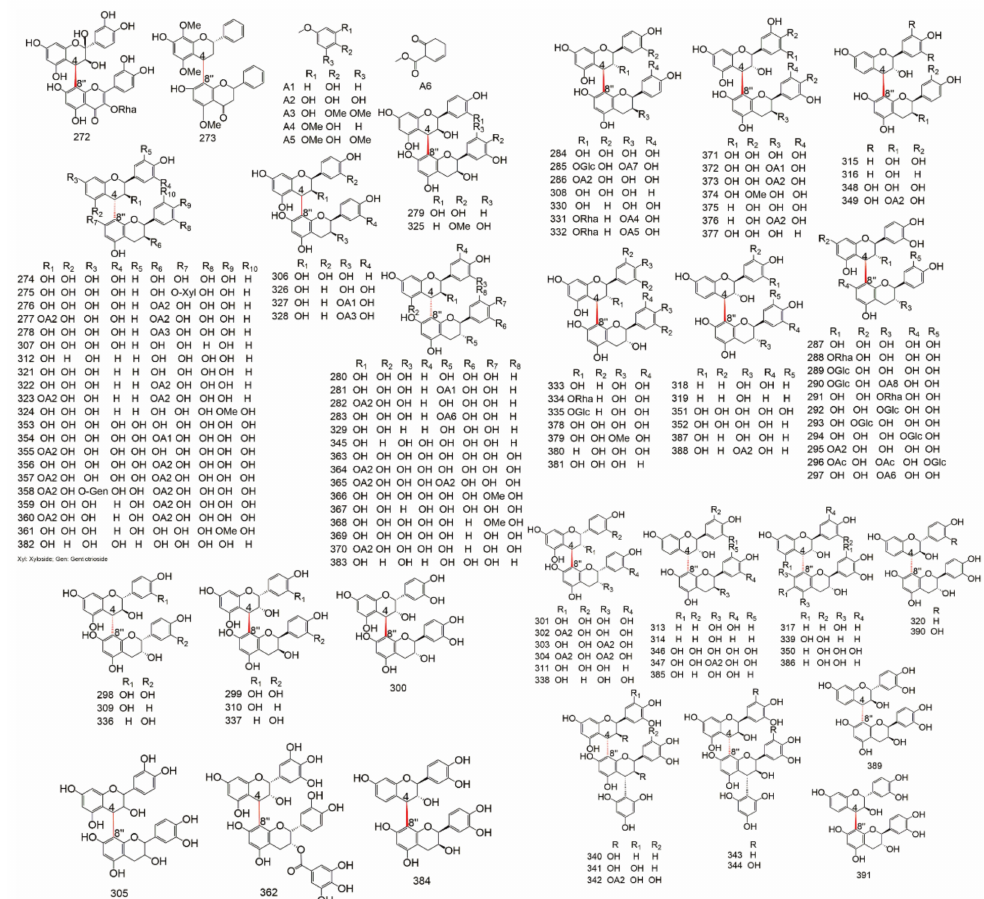
Figure 7. The structure of 4-8 (cid:48)(cid:48) type